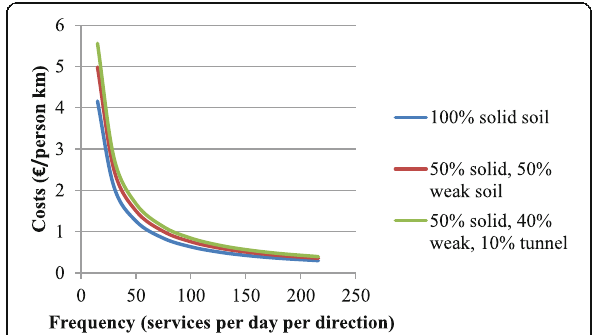
Fig. 6 Relation between the average unit costs and transport service